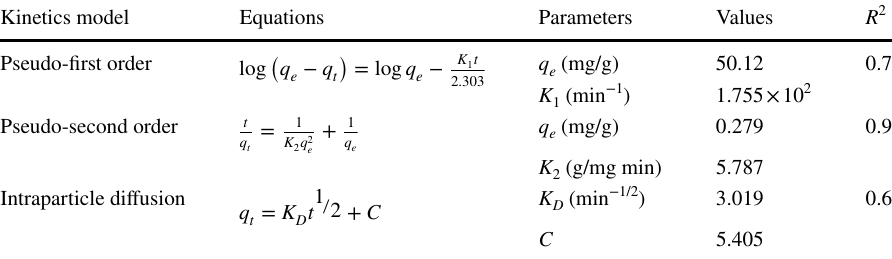
Table 2 Summary of parameters for various kinetic models by chicken feather